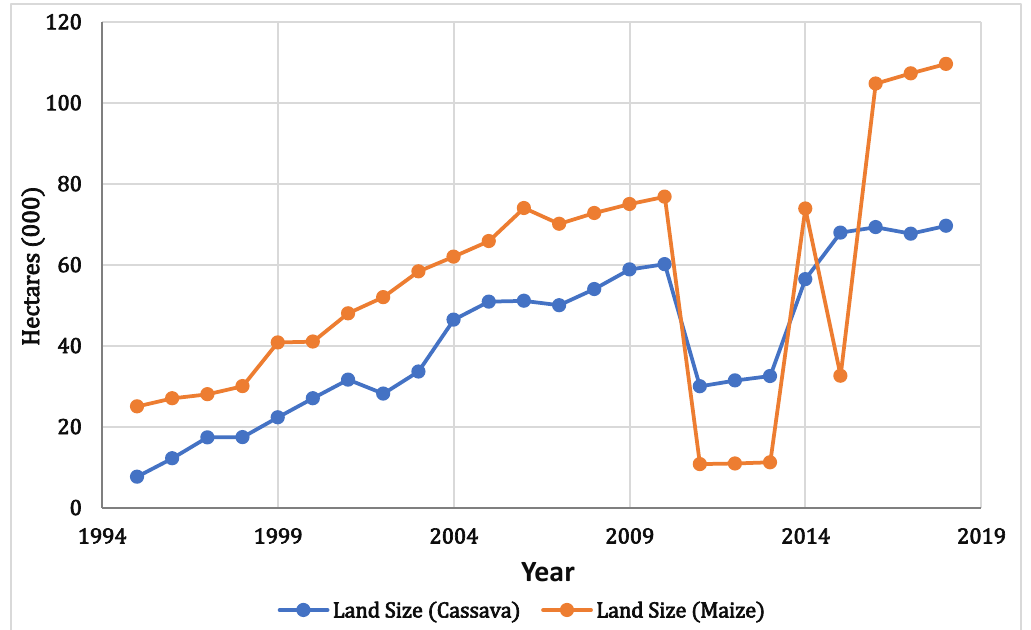
Figure 5. Lagos Cultivated land area for Cassava and Maize production through time (1995 – 2018).